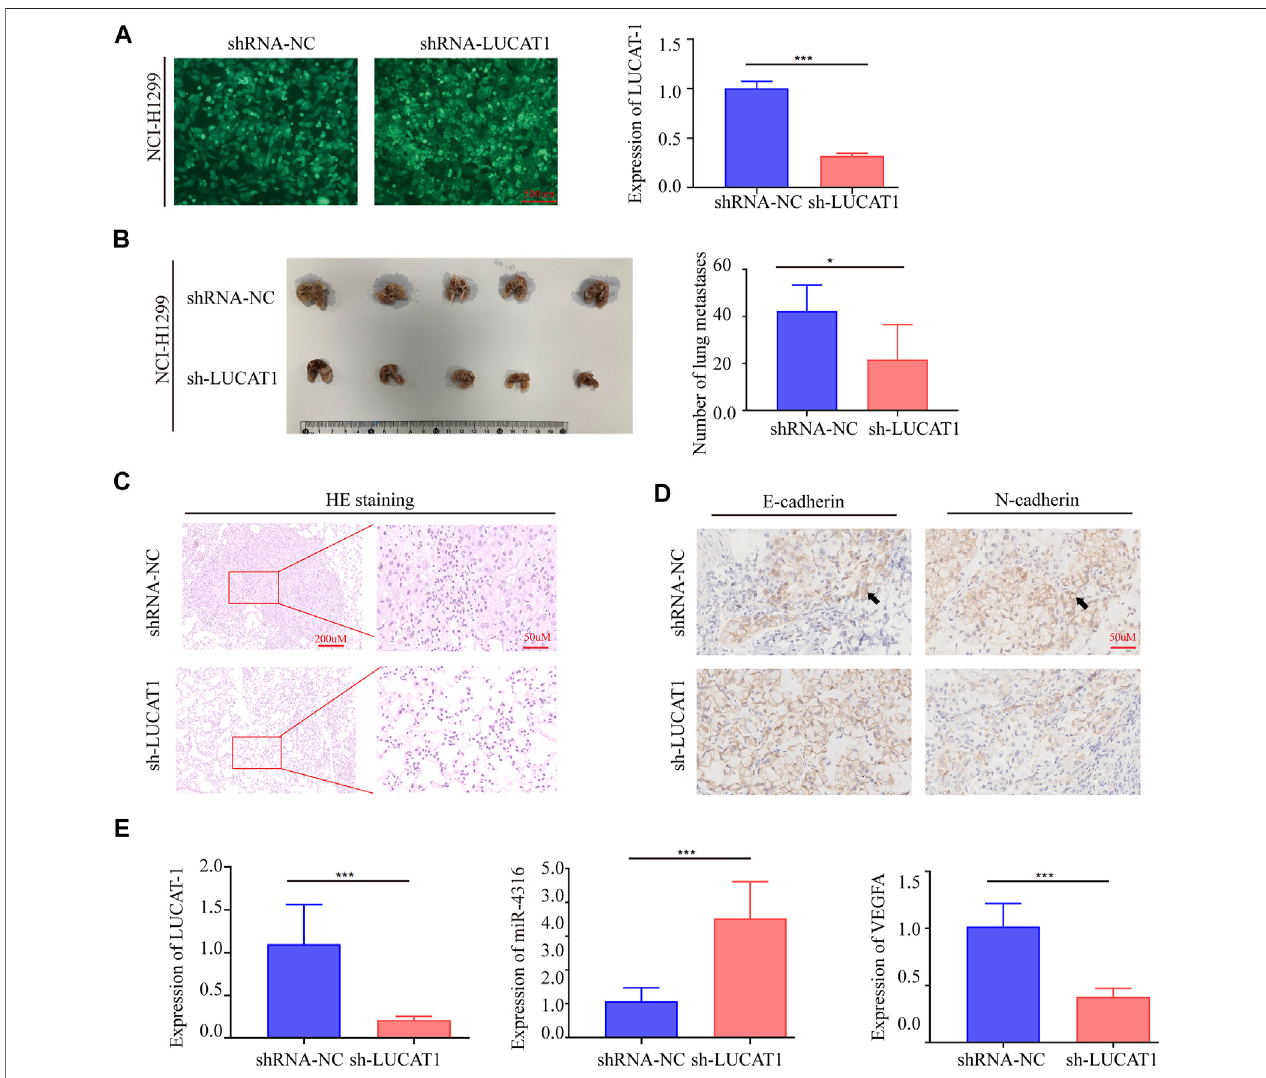
FIGURE 4 | Silencing LUCAT1 inhibits tumor metastasis in vivo . (A) qRT-PCR results for knockdown ef fi ciency of LUCAT1 in A549 cells by shRNAs. Scale bar: 200 µm. (B) Numberofmetastaticnodulesinthelungtissues. (C) ThemicroscopicimagesoflungtissuesectionsstainedbyHE. (D) IHCwereperformedtoquantitythe expression of E-Cadherin and N-Cadherin in metastatic nodes of mouse model. (E) qRT-PCR was performed to detect the expression of LUCAT1, miR-4316 and VEGFA of metastatic nodes formed from sh-LUCAT stable cells. p -values were determined by two-tailed student ’ s t-test (* p < 0.05; ** p < 0.01; *** p < 0.001).